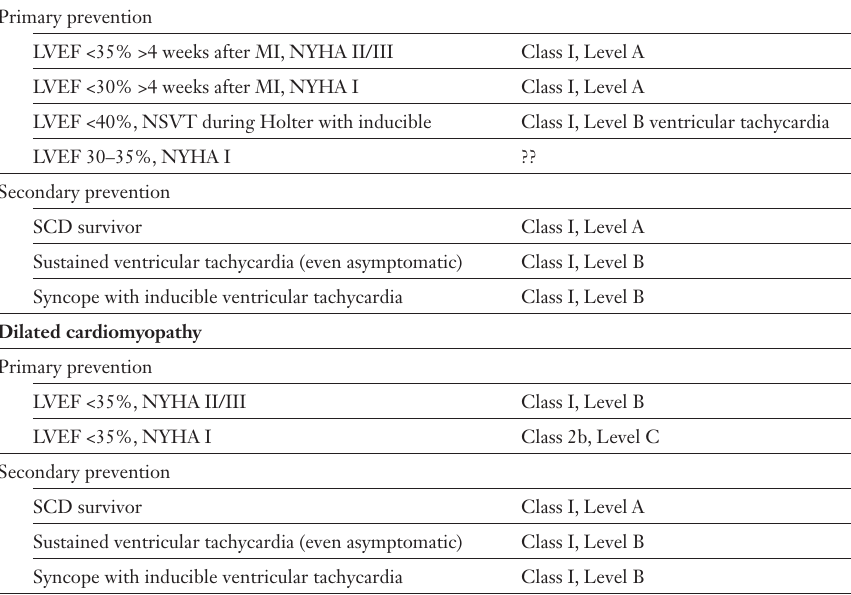
Indication for ICD im- plantation according to current